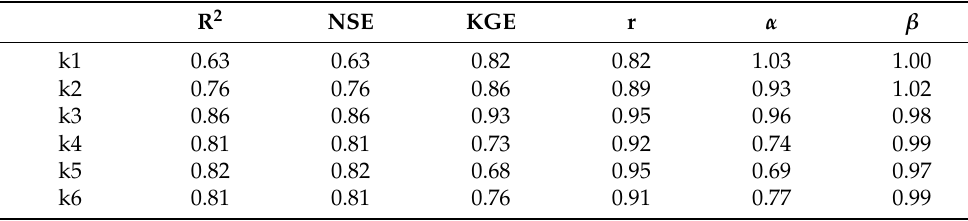
Figure 3. Comparison of the predicted values and the measured values in the high-water period. a(1) , b(1) , c(1) , d(1) and e(1) are the predicted and measured values for k1 to k5 folds, respectively, and f(1) is the predicted and measured values for all validation sets. a(2) , b(2) , c(2) , d(2) and e(2) are the scatter plots of the predicted and measured values for k1 to k5 folds, respectively, and f(2) is the scatter plot for all validation sets from k1 to k5. Table 2. Evaluation of low-water